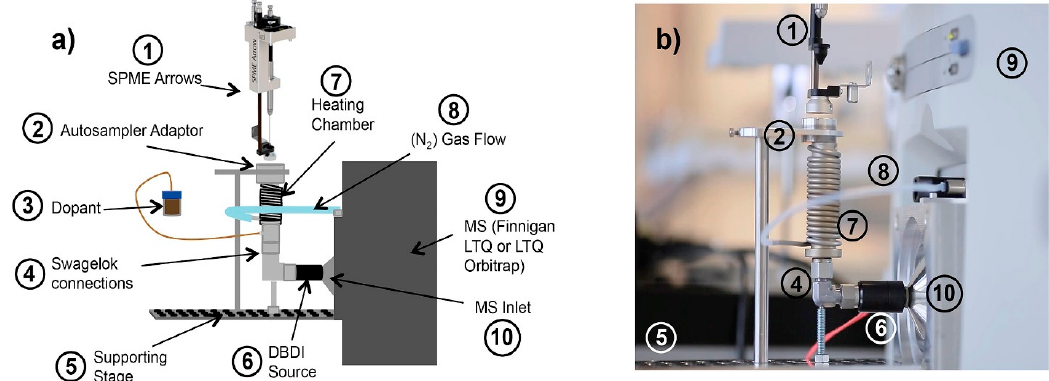
Figure 8. Schematic drawing ( a ) and image ( b ) of the sample introduction system (with and without dopant), source, and dielectric barrier desorption ionization (DBDI) interface with the mass spectrometer. Figure reprinted with permission of Elsevier from Reference [59], 2020.